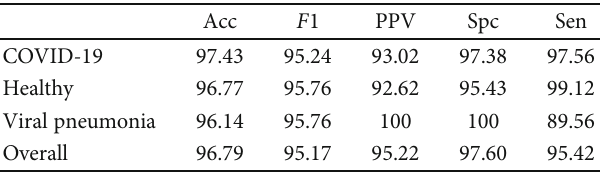
Table 6: Performance of the best CNN on dataset prepared by [21]